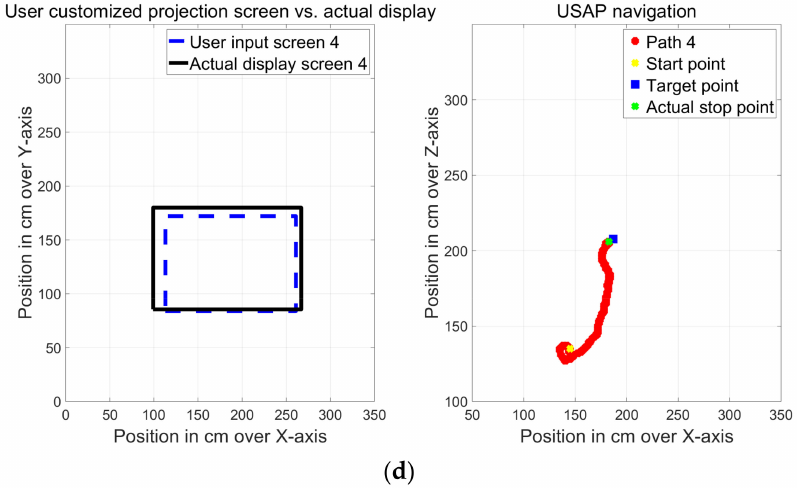
Figure 15. Customized screen accuracy and USAP platform navigation performance: ( a ) Customized screen 1 and USAP’s first path, ( b ) customized screen 2 and USAP’s second path, ( c ) customized screen 3 and USAP’s third path, and ( d ) customized screen 4 and USAP’s fourth